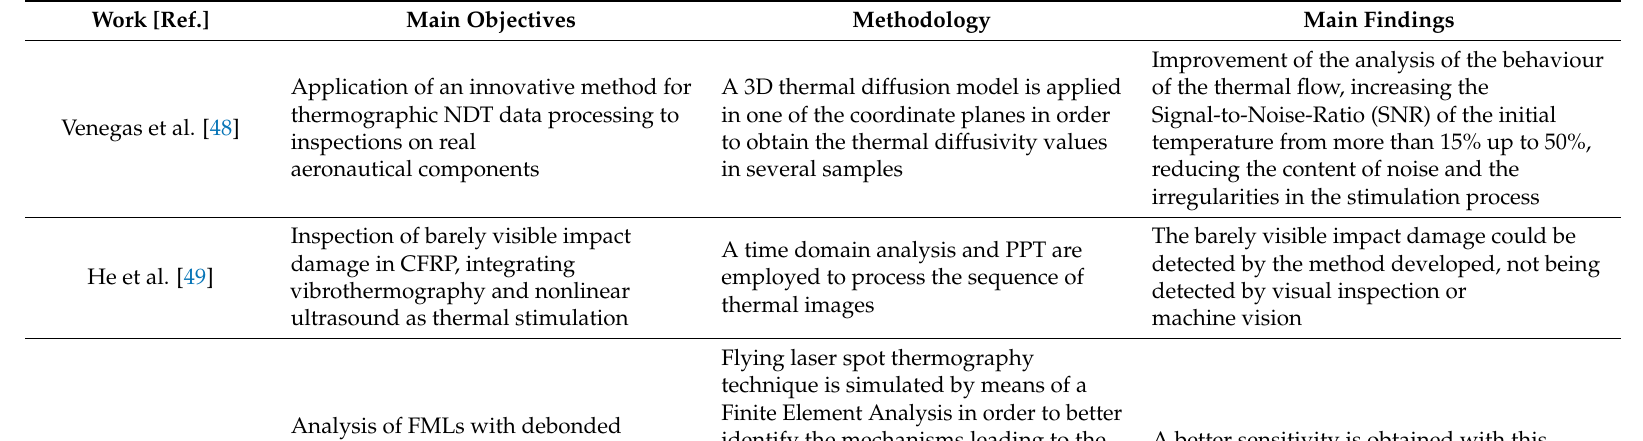
Table 2. Review of IRT studies in civil